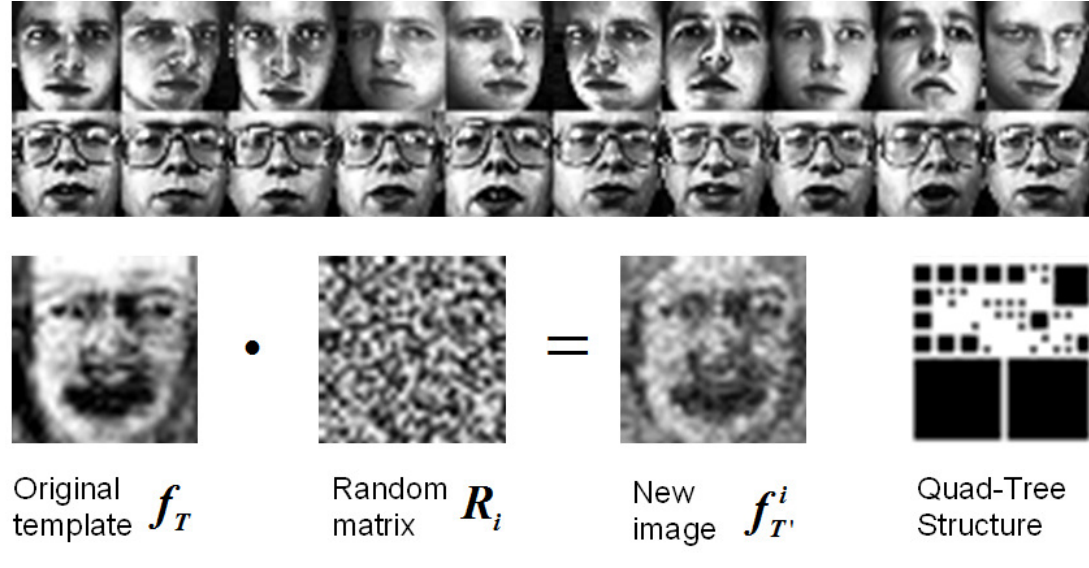
Figure 5. Example of template face generation and random matrix introduction for the Oivetti face database